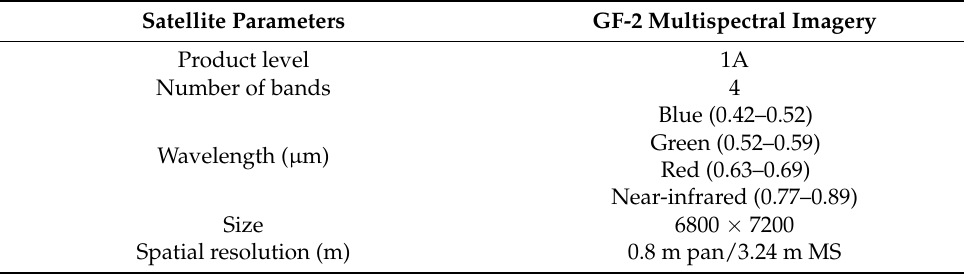
Table 1. Detailed information of GF-2 multispectral